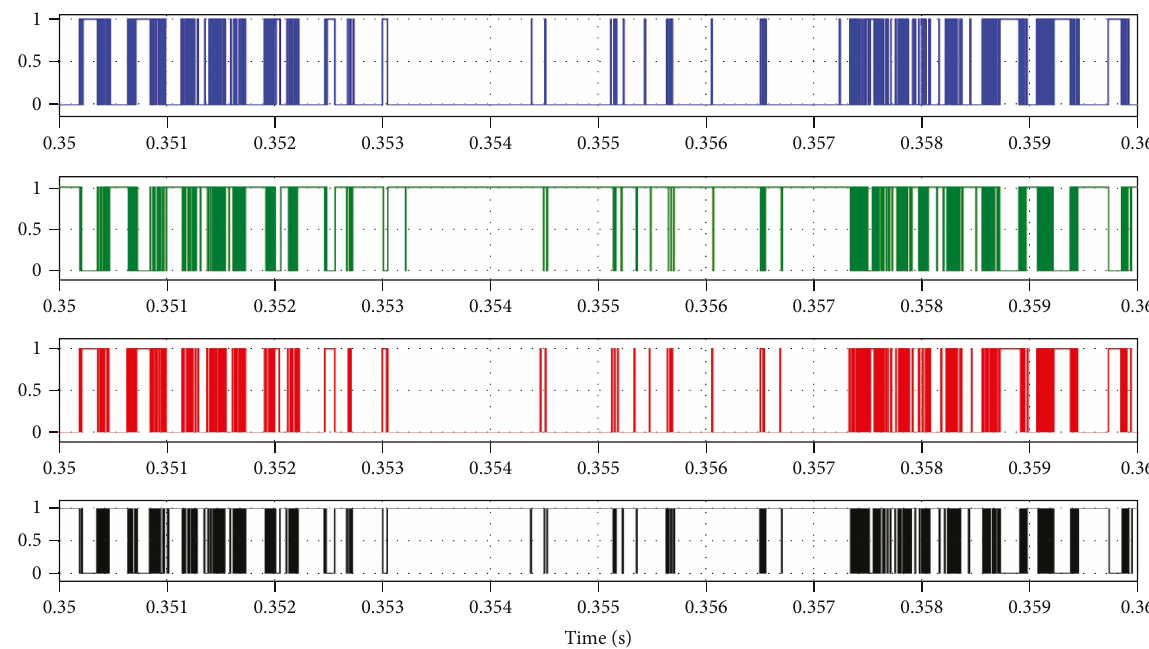
Figure 14: Switchings belonging to a phase when the PI λ -MPC hybrid controller is enabled.